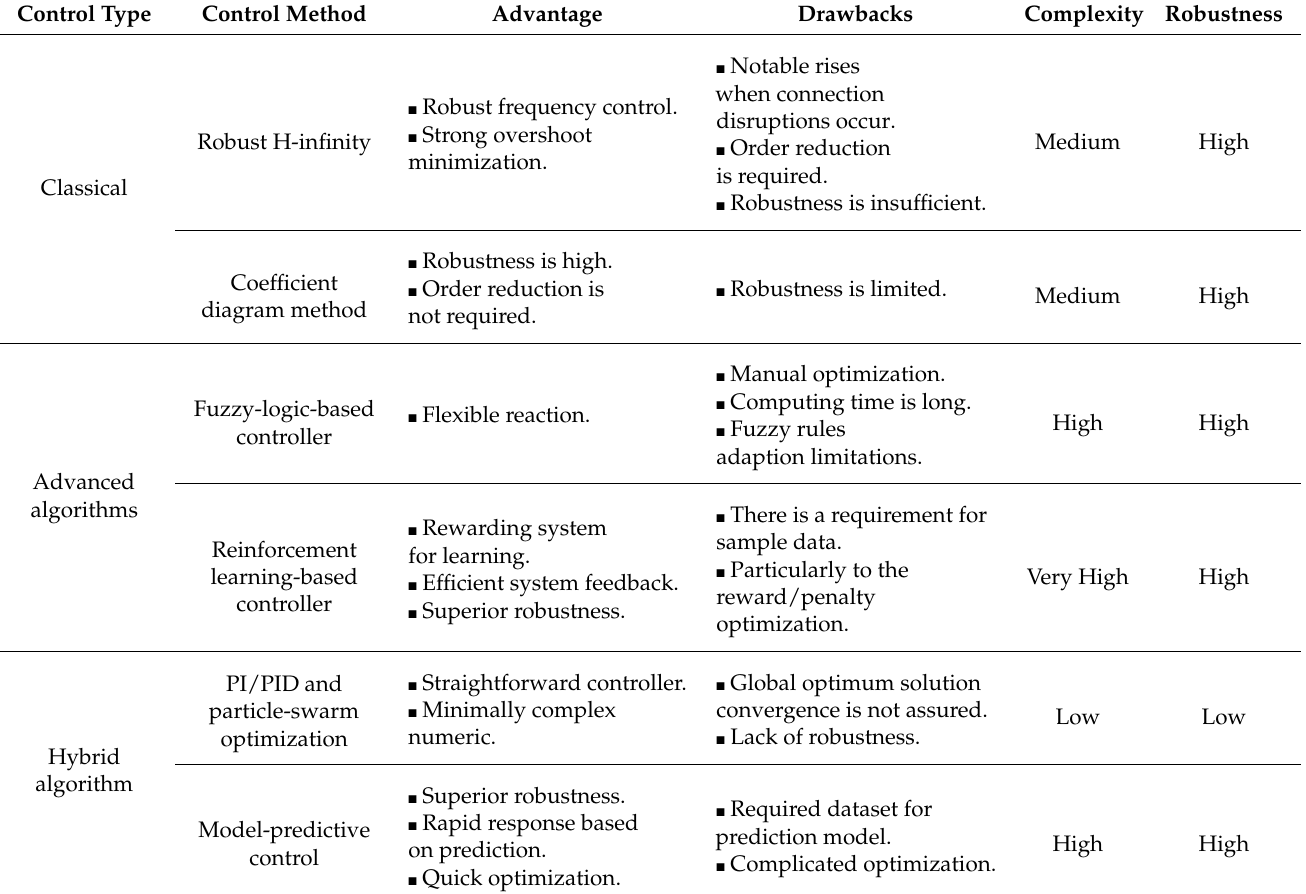
Table 2. Islanded microgrids VI control approaches